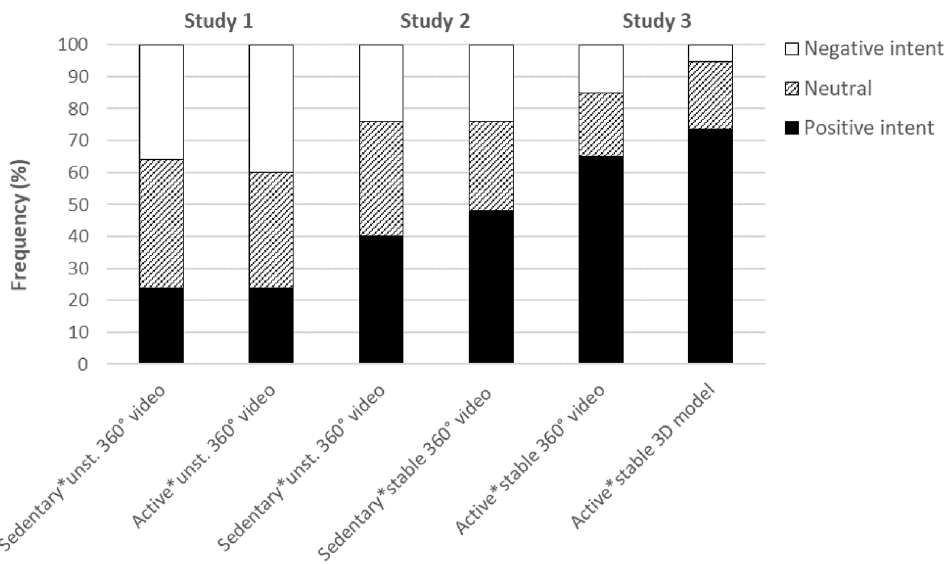
0–10 scale, but for the sake of simplicity the ratings were here conflates as “Positive intention” (rating 0 to 4), “Neutral” (raing point 5, which corresponds to the varbal cue “neither agree neither disagree”), and “Negative intention” (ratings 6 to 10).